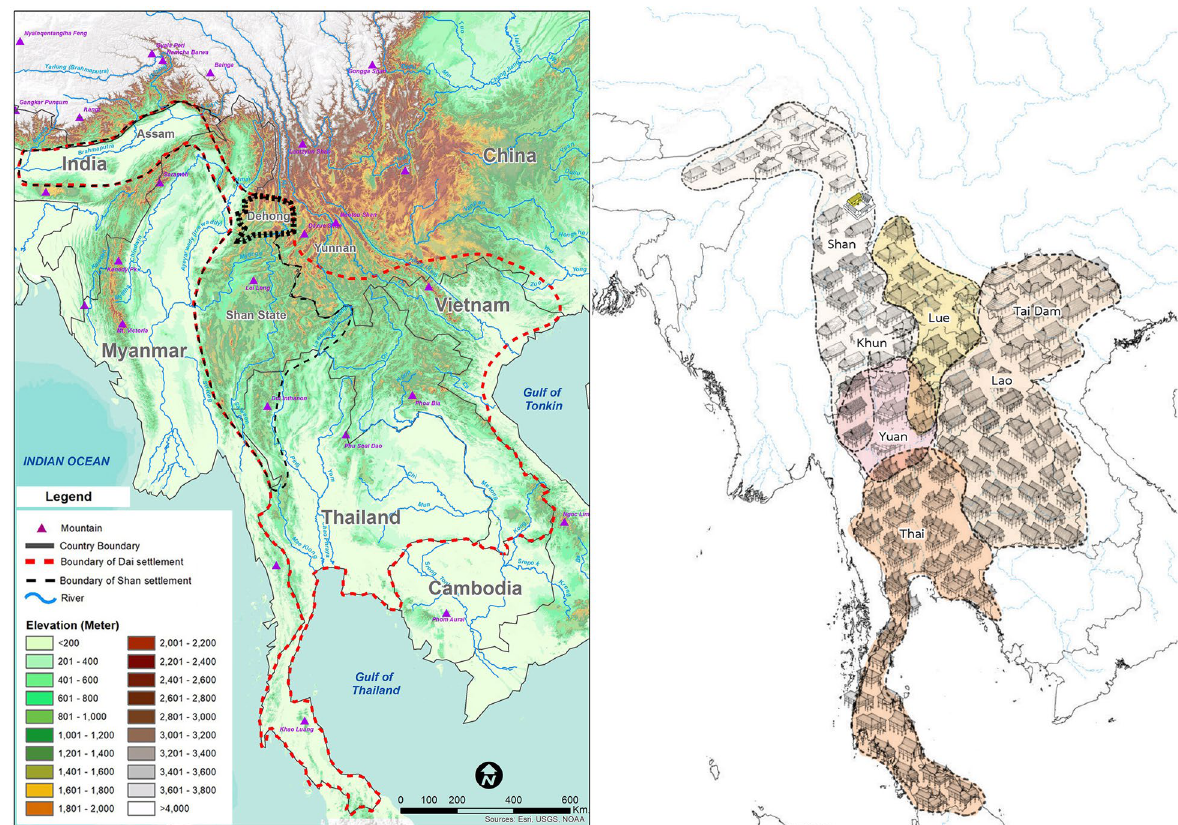
Fig. 1 Left: map of Dai settlements, adapted from Oranratmanee (2020). Right: distribution of Dai house forms (Source: the